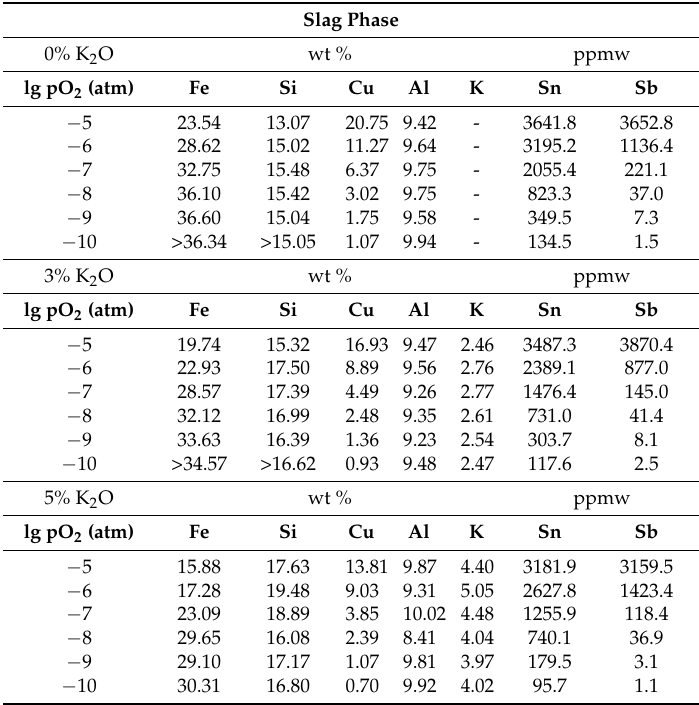
Table A3. Concentrations of iron, silicon, copper, aluminum, potassium, tin and antimony in slag phase. The concentrations of tin and antimony are shown in ppmw. LA-ICP-MS results have been used below 10 − 8 atm oxygen partial pressure for tin, and below 10 − 6 atm for antimony.